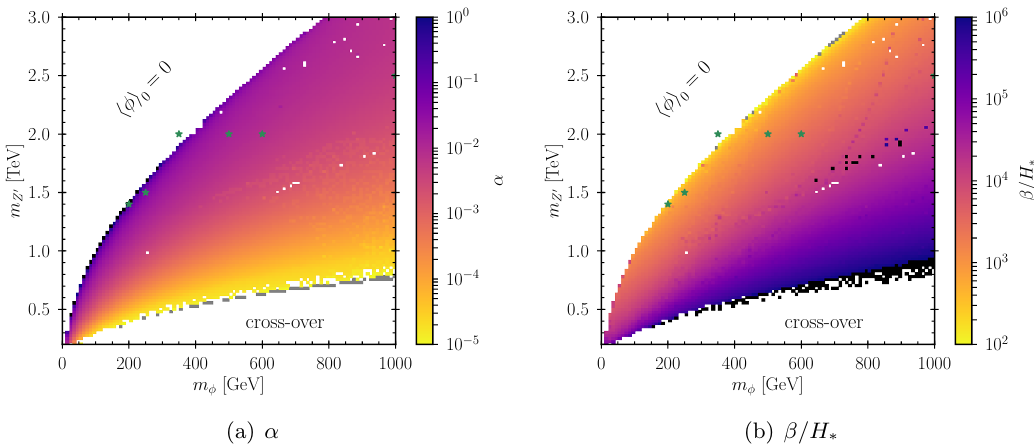
Figure 20 . (cid:11) and (cid:12)=H (cid:3) as a function of the U(1) ‘ breaking scalar mass m (cid:30) and the U(1) ‘ gauge boson mass m Z 0 in the case of negligible portal coupling (cid:21) p . Gray points correspond to under(cid:13)ows ( (cid:11) < 10 (cid:0) 5 or (cid:12)=H (cid:3) < 10 2 ), black dots are over(cid:13)ows ( (cid:11) > 1 or (cid:12)=H (cid:3) > 10 6 ). See appendix C for the values of the starred benchmark